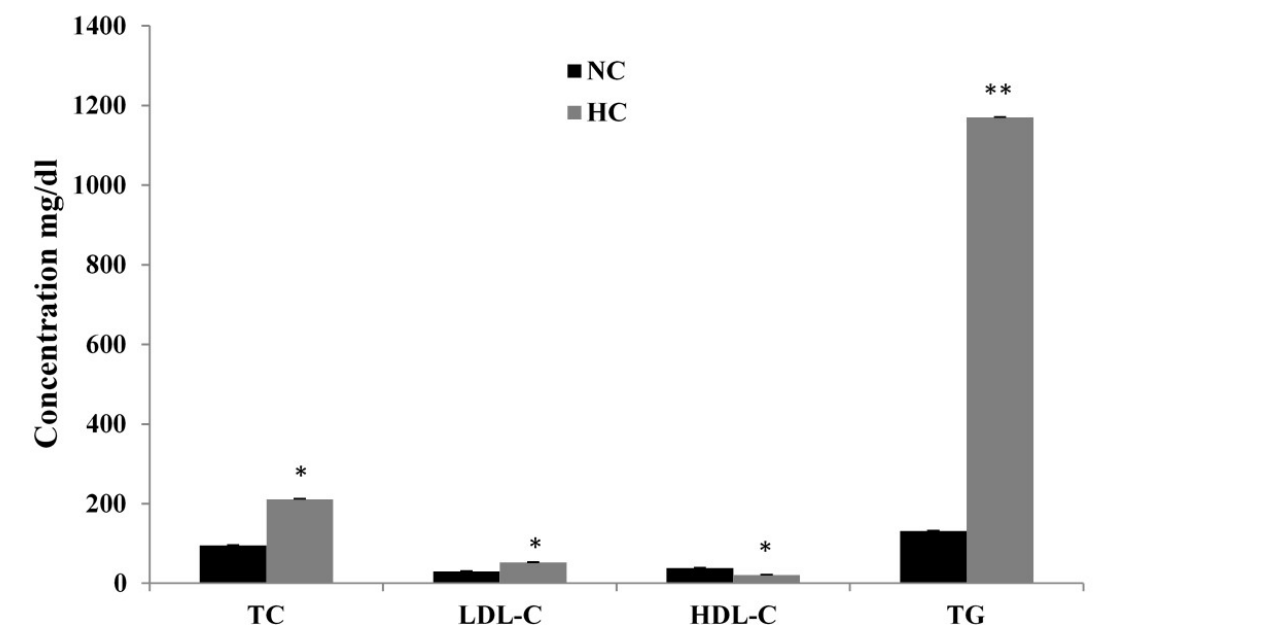
FIGURE 2 - Effect of Triton WR-1339 on plasma lipid levels after 18 h. Values are presentd as the mean ± SEM ( n = 8) in each group. NC, normal control group; HC, hyperlipidemic control group; TC, total cholesterol; LDL-C, low-density lipoprotein- cholesterol; HDL-C, high-density lipoprotein-cholesterol; TG, triglycerides; HC is compared to NC.* p < 0.001, * *p <